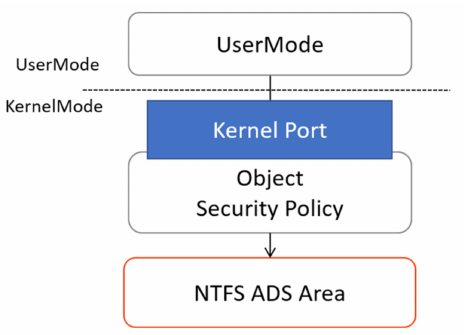
Figure 7. Object’s policy setting through a kernel port.